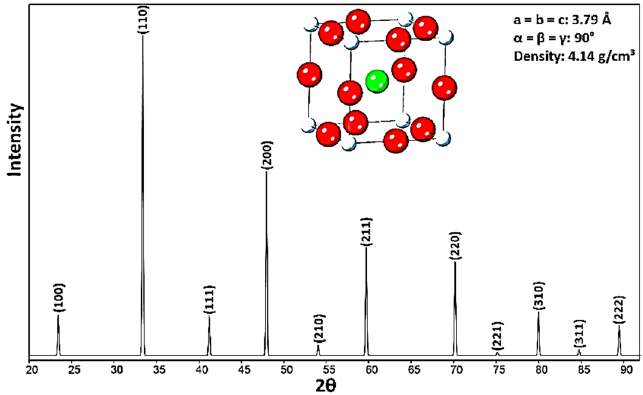
Figure 2. X-ray diffraction of CaTiO ₃ (powder sample).